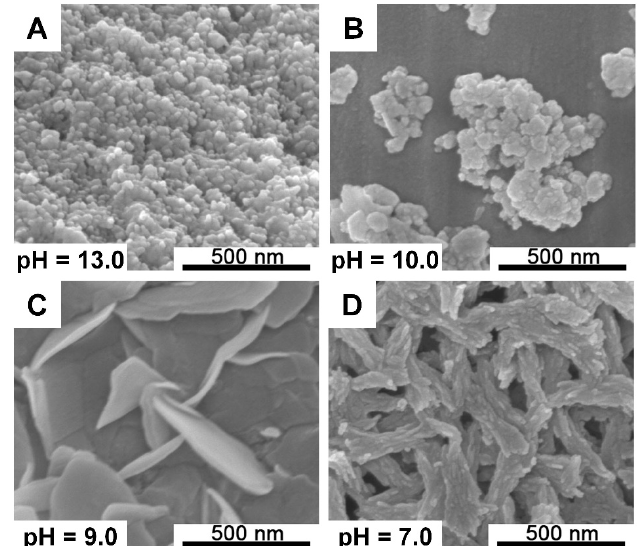
Figure 4. SEM images of CaP structures observed in scale-up experiments. ( A ) pH = 13.0; ( B ) pH = 10.0; ( C ) pH = 9.0; ( D ) pH =